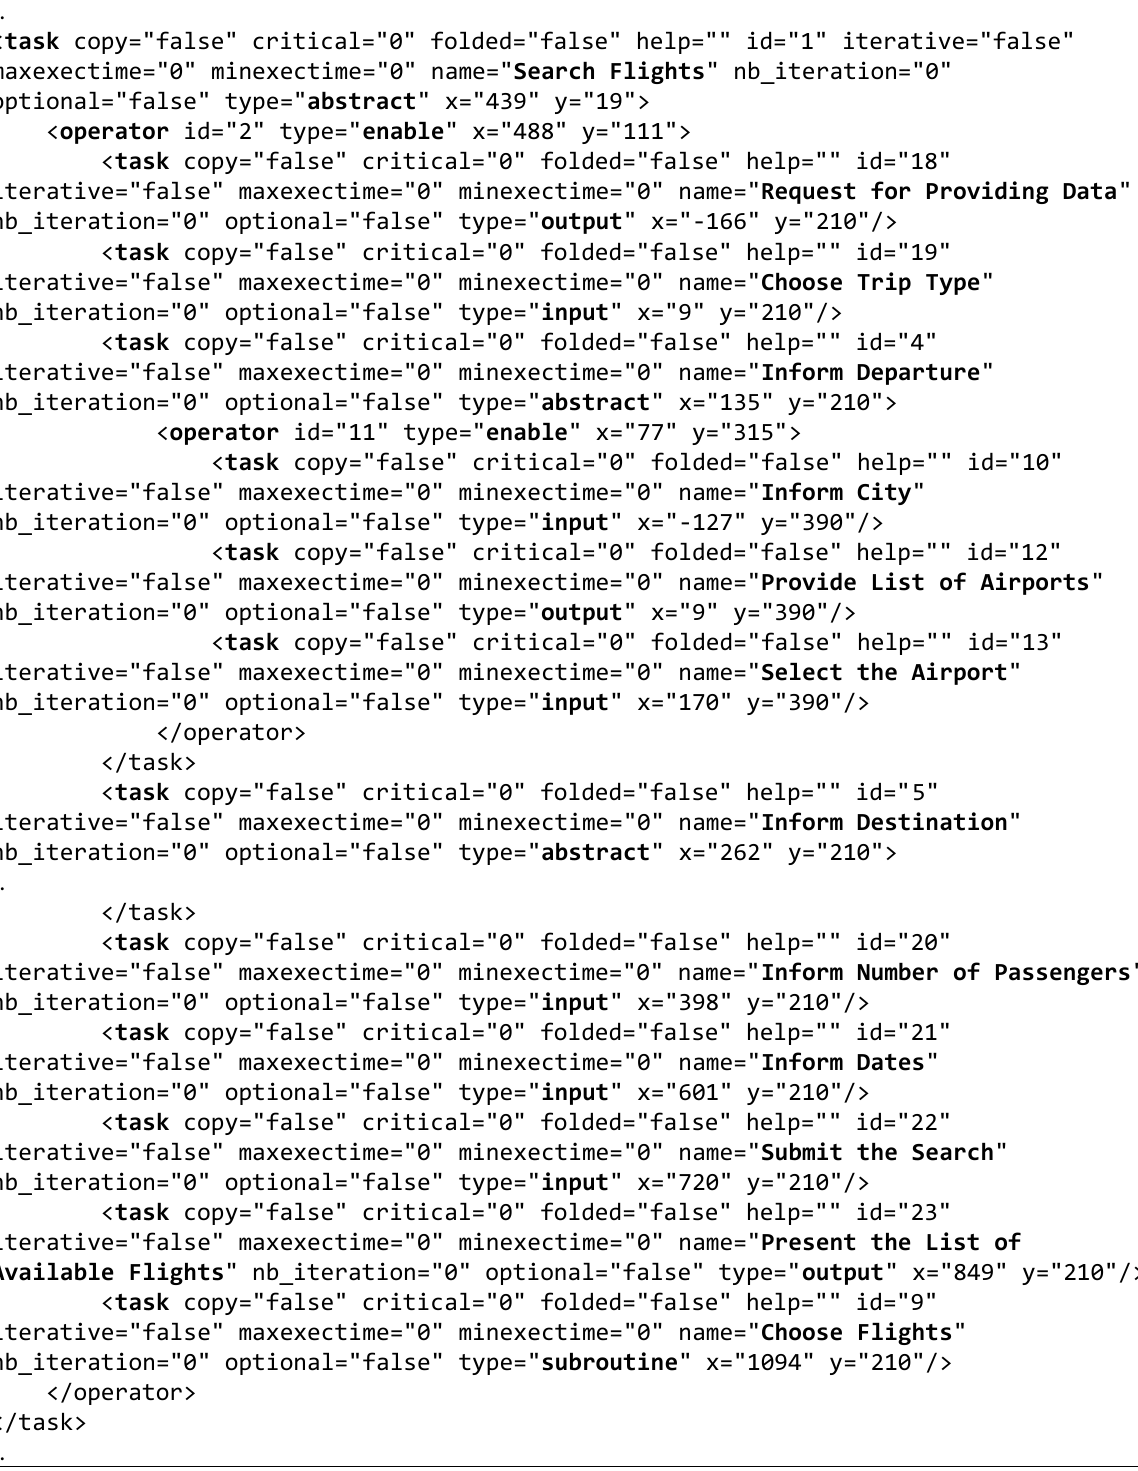
Figure 21. Task Model for the User Story “Flight Tickets Search” represented as an XML file with the components for testing